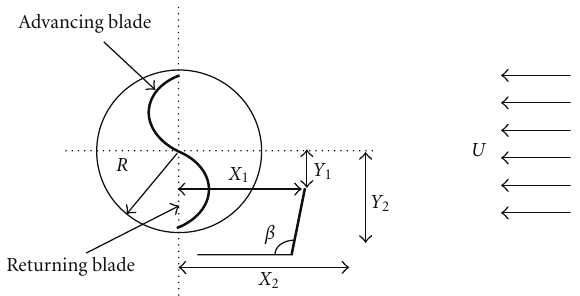
Figure 5: Schematic of modified Savonius rotor with geometrical parameters of deflector plate